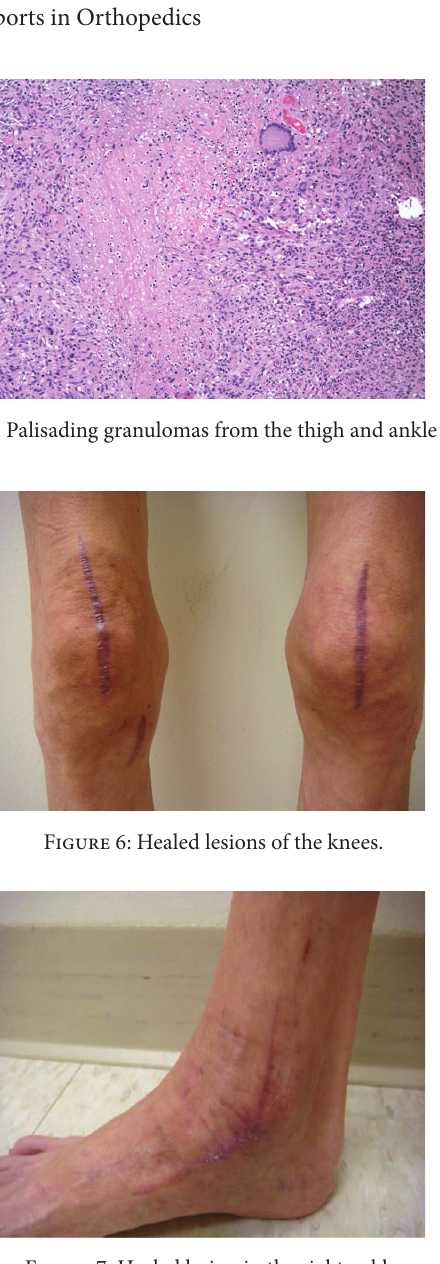
Figure 7: Healed lesion in the right ankle.